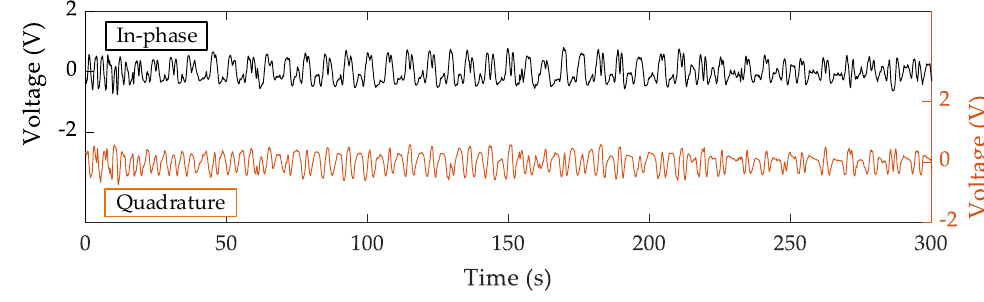
Figure 2. In-phase and quadrature Doppler radar signals during the measurements. The participant was breathing normally in front of the radar sensor. was breathing normally in front of the radar